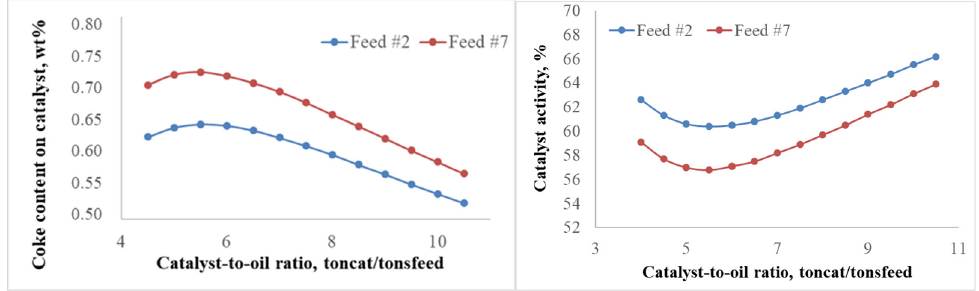
Figure 11. Effect of the catalyst-to-oil ratio on coke content and relative catalyst activity.